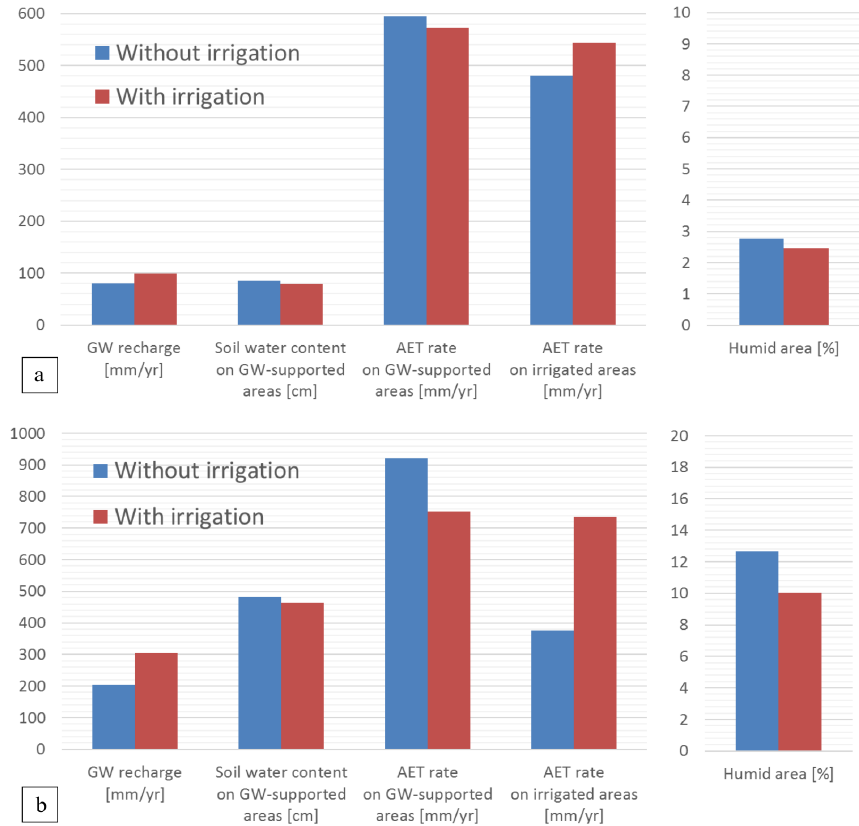
Figure 7. Comparison of some indicators obtained from CWatM–MODFLOW simulation with and without irrigation in annual average values in 1983–2016 for Seewinkel (a) and in 1997–2009 for Bhima (b) . Note that the units are different for each variable. Areas were considered humid when the groundwater supported soils for at least 4 months of